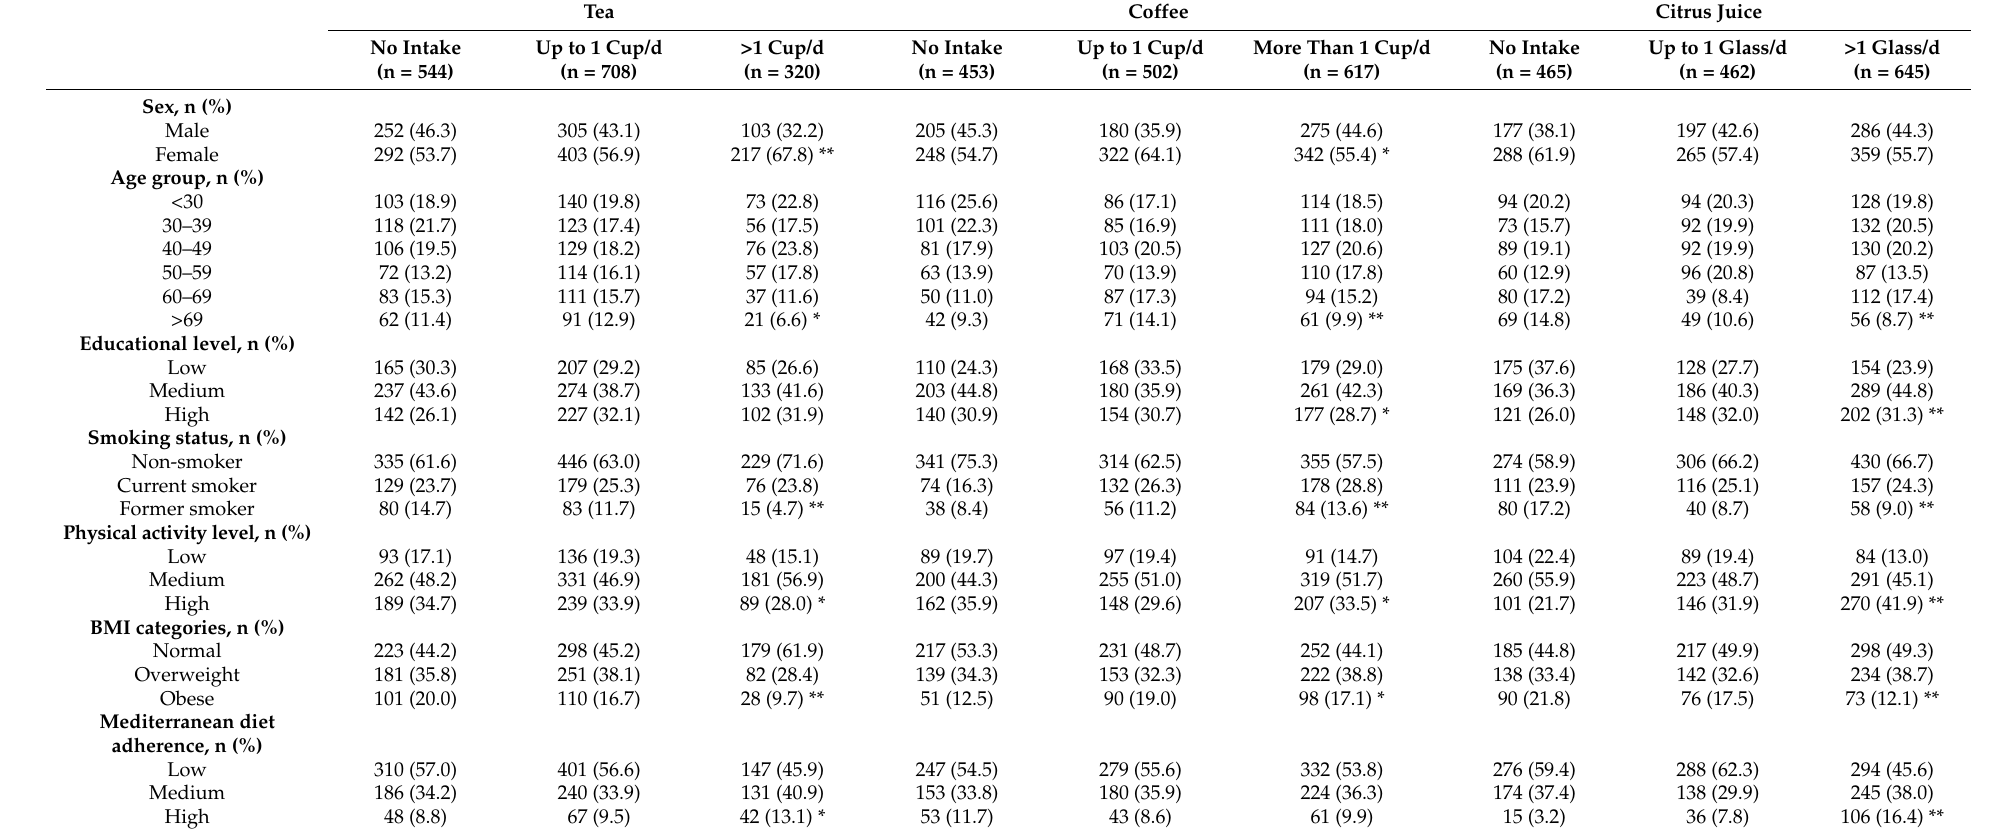
Table 2. Background characteristics of the study sample by consumption of individual non-alcoholic polyphenol-rich